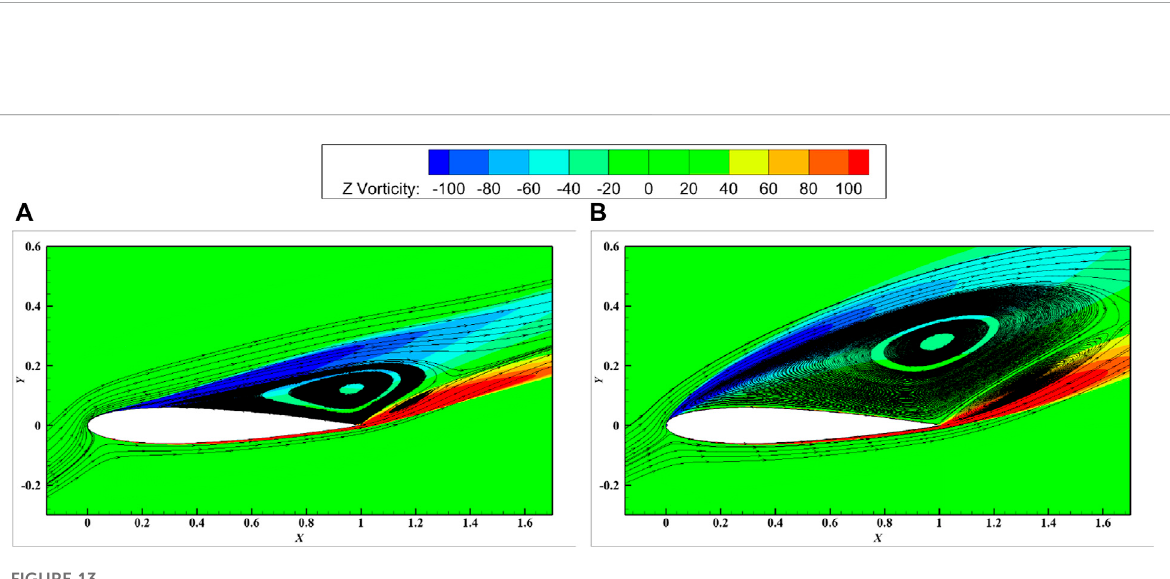
FIGURE 13 Schematicdiagram of the surface streamline and vorticity of the NACA0012 original and semi-circular leading edge erosion airfoil ( h 1 = 0.5% c ). ( (A) : Original airfoil ( i = 18 ° ); (B) : Semi-circular erosion airfoil ( i = 18 °